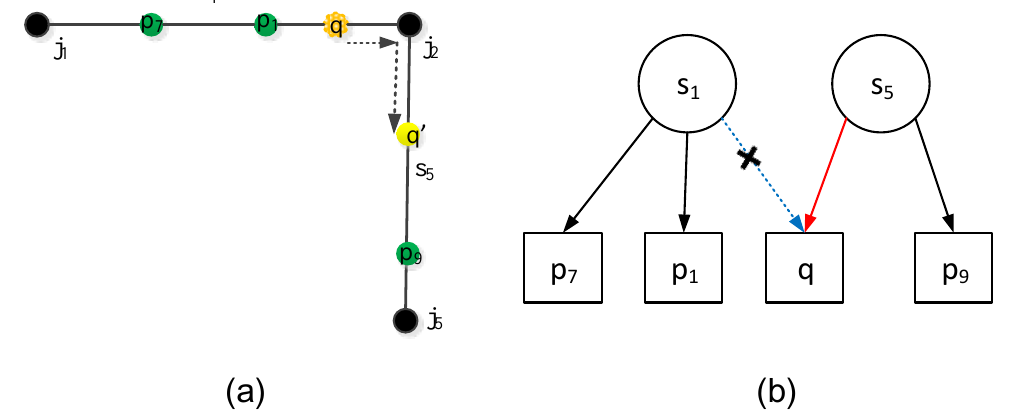
Figure 3. An example of bridgeable edges. ( a ) A query object in network; ( b ) The schematic of bridgeable